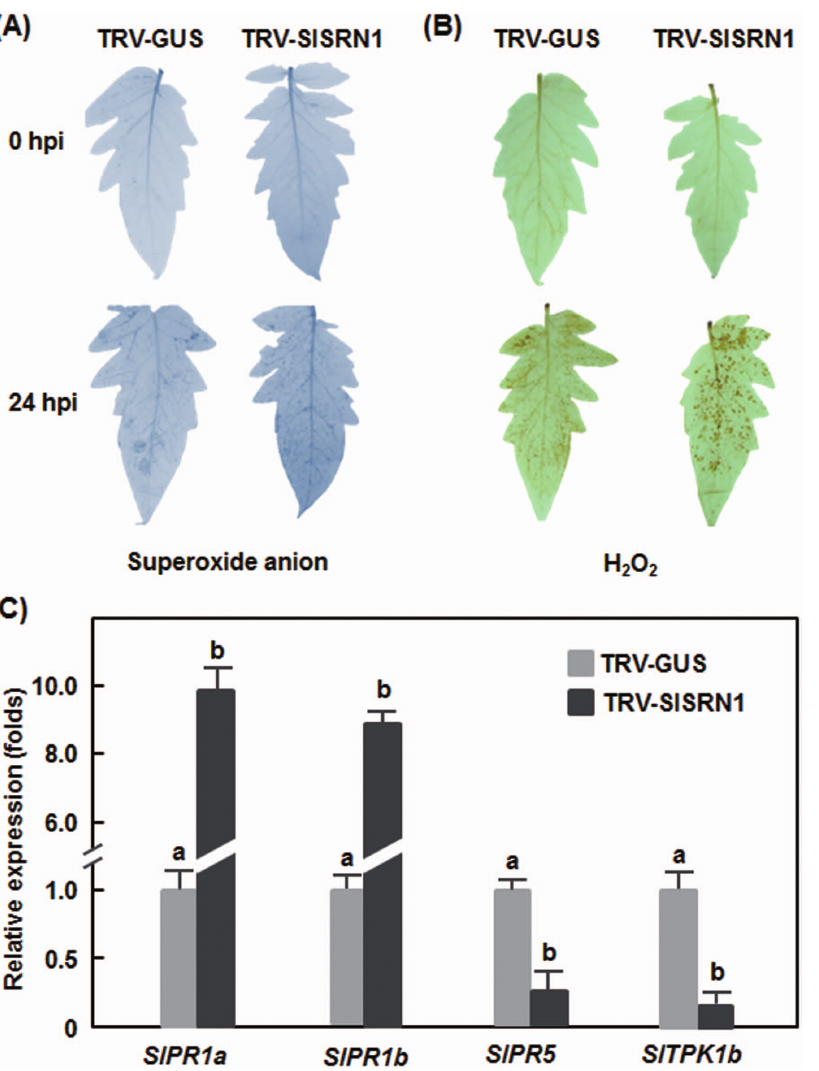
Figure 6. Altered generation of reactive oxygen species and expression of defense genes in SlSRN1 -silenced plants after infection with B.cinerea. Two-week-old seedlings were infiltrated with agrobacteria carrying TRV-SlSRN1 or TRV-GUS and were inoculated by spraying with spore suspension of B. cinerea at 2 weeks after VIGS infiltration. Leaf samples were collected at 0 (as controls) and 24 hr after inoculation for detection of reactive oxygen species and analyses of defense gene expression. A and B. Detection of H 2 O 2 and superoxide anion by DAB and NBT staining, respectively. Representative stained leaves are shown and the experiments were repeated twice with similar results. C. Expression of defense genes after infection with B. cinerea . Relative expression levels were calculated by comparing with the corresponding values at 0 h after treatment (as a control). At least 6 leaves from 6 individual silenced or control plants were used for each experiment. Data presented are the means 6 SD from three independent experiments and different letters above the columns indicate significant differences at p , 0.05